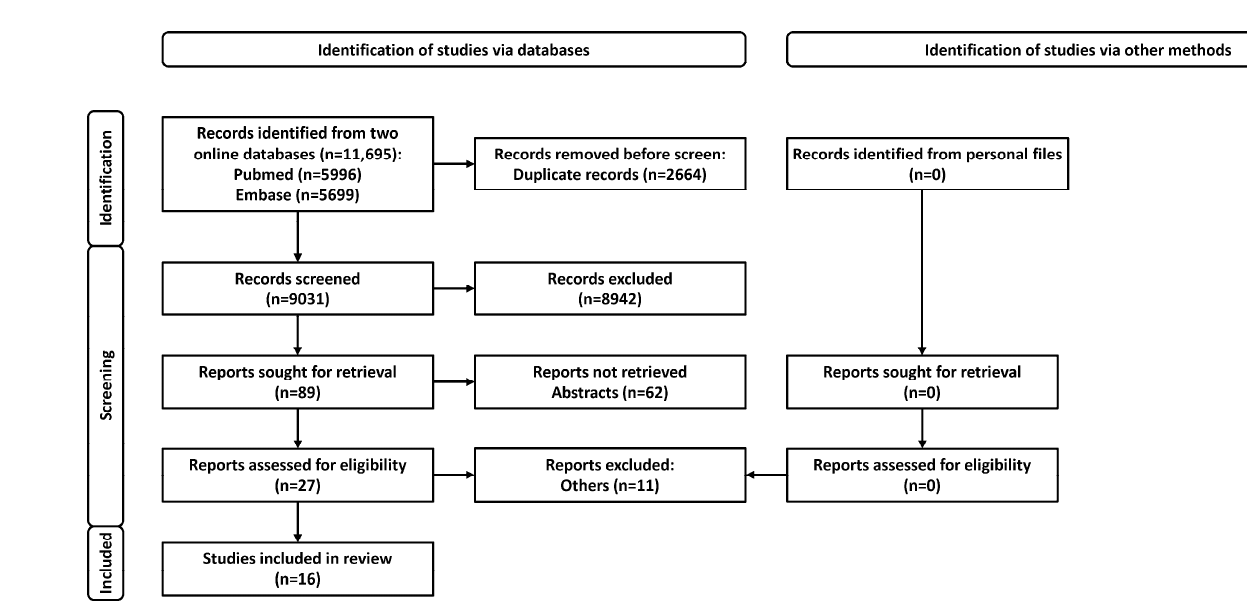
Figure 1. Study selection process for the systematic review.